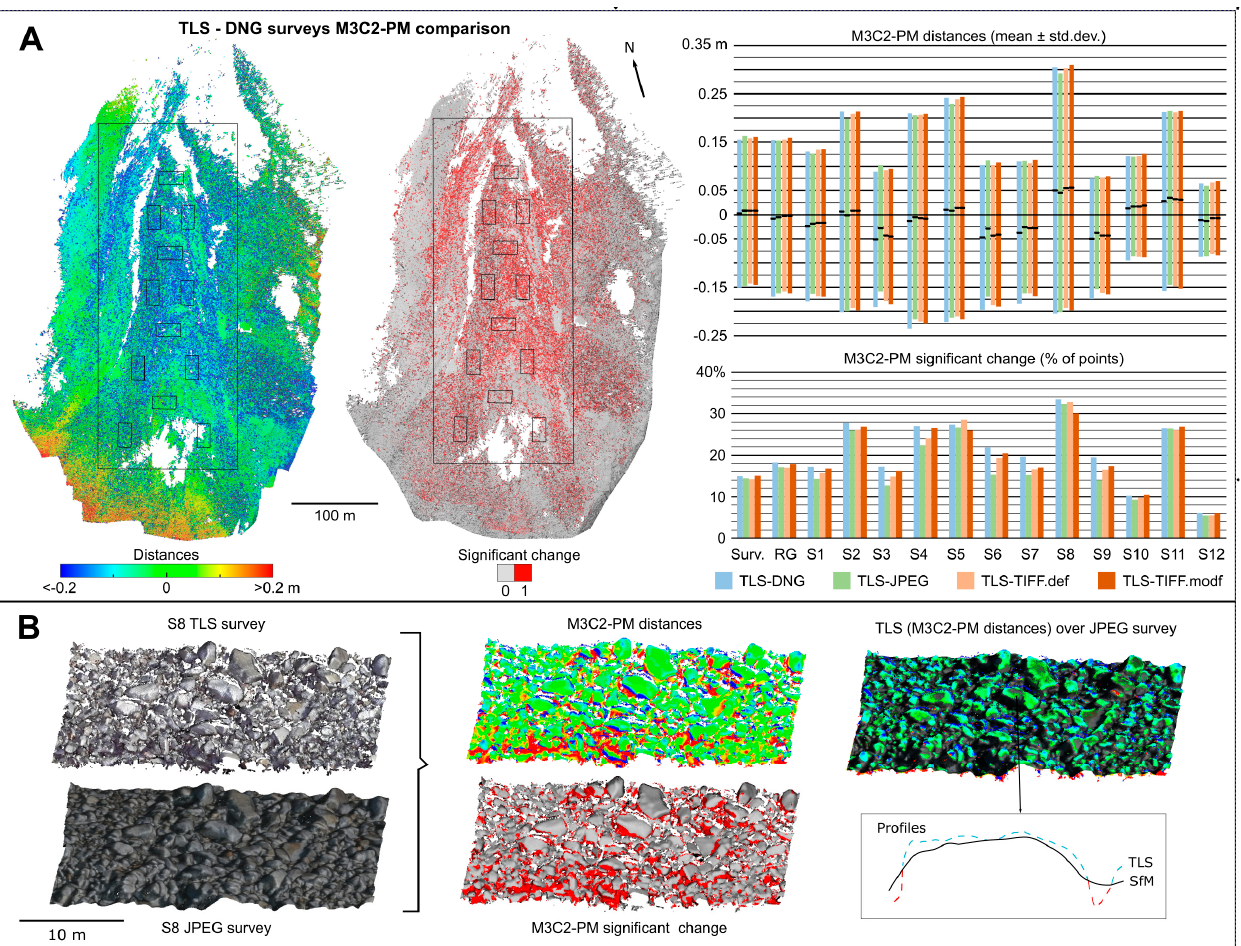
Figure 10. M3C2-PM comparisons between TLS and SfM surveys. Distances less than − 0.2 m are shown in blue and distances greater than 0.2 m are shown in red. Significant changes are shown in red. ( A ) M3C2-PM distances and significant change values and distribution. M3C2-PM distances show predominantly negative values due to the top viewpoint of the survey. At the level of detail presented, there is no difference between TLS and SfM surveys. Therefore, only the TLS-DNG comparison image is shown. ( B ) Detail of the differences between TLS-DNG reconstructions in